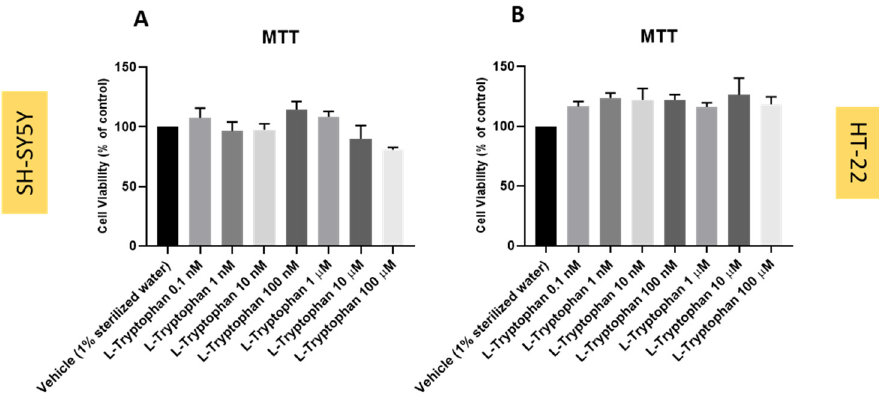
Figure 11. Effect of 48 h-incubation of 0.1 nM-100 µ M of L-tryptophan on the viability of ( A ) SH-SY5Y cells and ( B ) HT-22 cells, determined by MTT methodology. The results represent the mean ± SEM of three independent experiments, expressed as the percentage of the vehicle (100%).